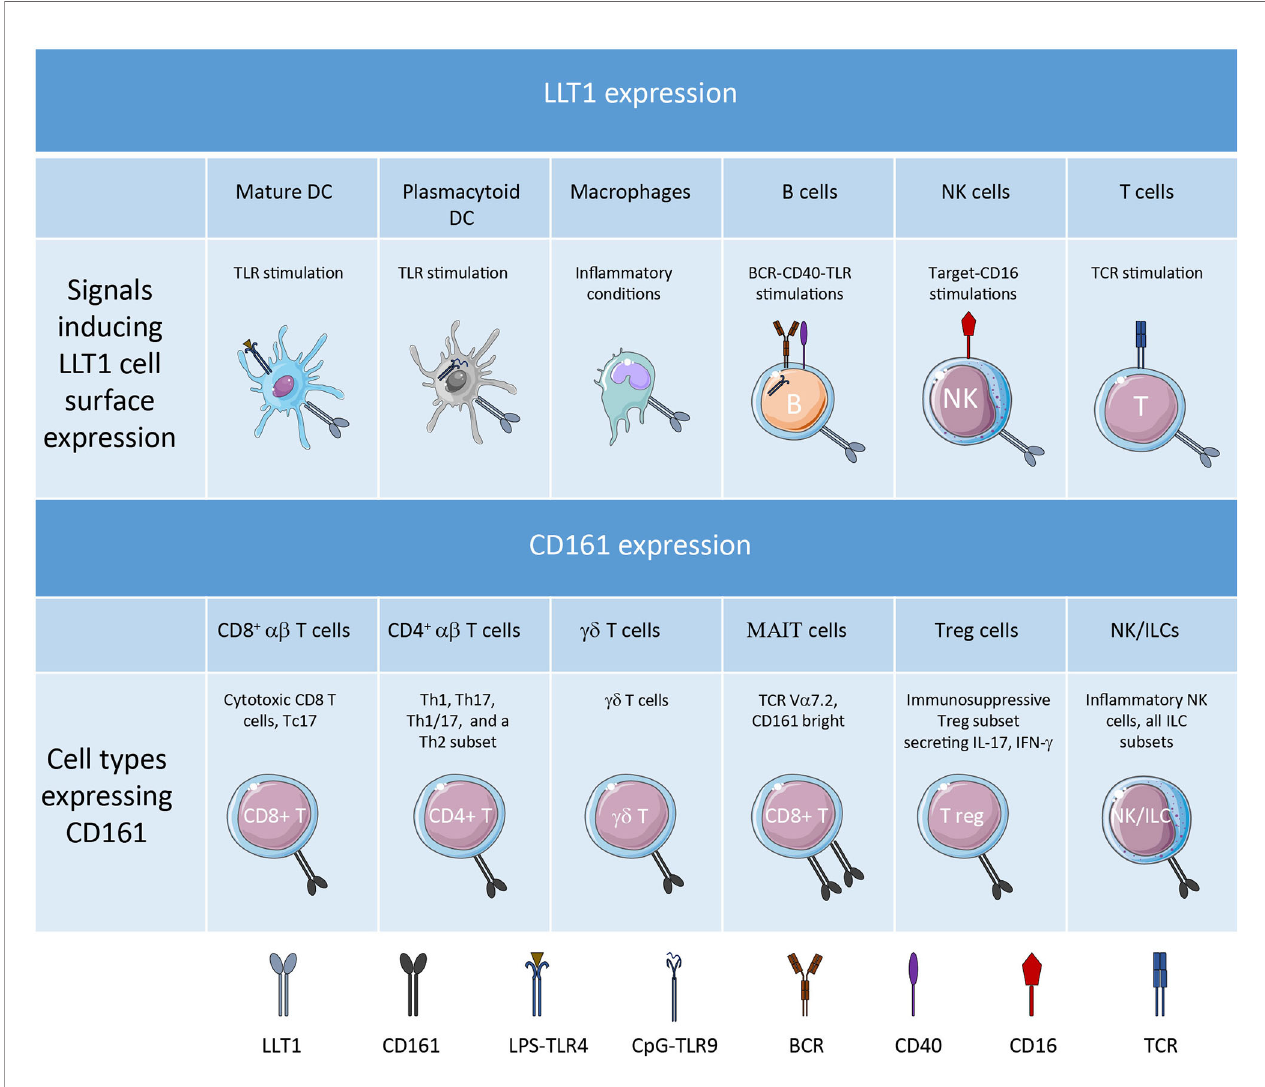
FIGURE 1 | LLT1 and CD161 expression pro fi